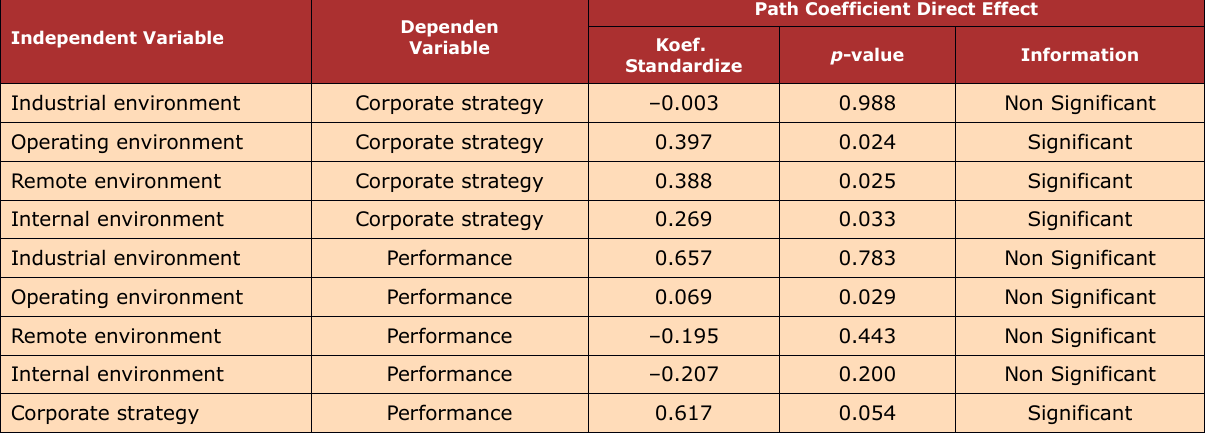
Table 1. Results of hypothesis